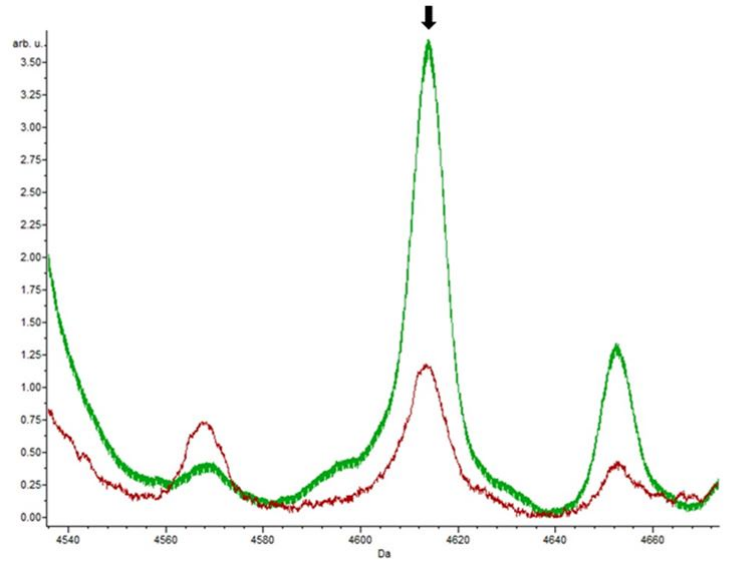
Figure 4. The red spectrum represents the control and the green spectrum was obtained by the action of teicoplanin. The arrow shows a peak at m/z 4652.66 with greater intensity in the presence of the antibiotic.